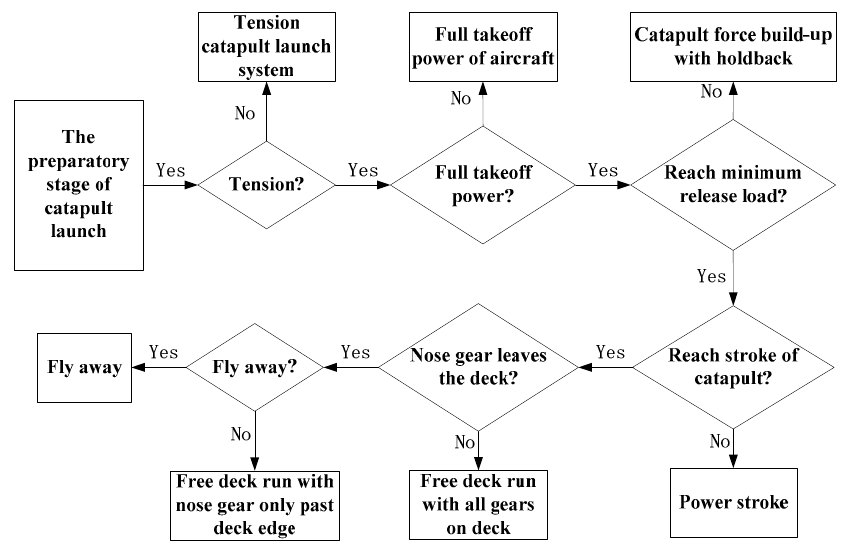
Figure 2. The flow chart of process for steam catapult launch.